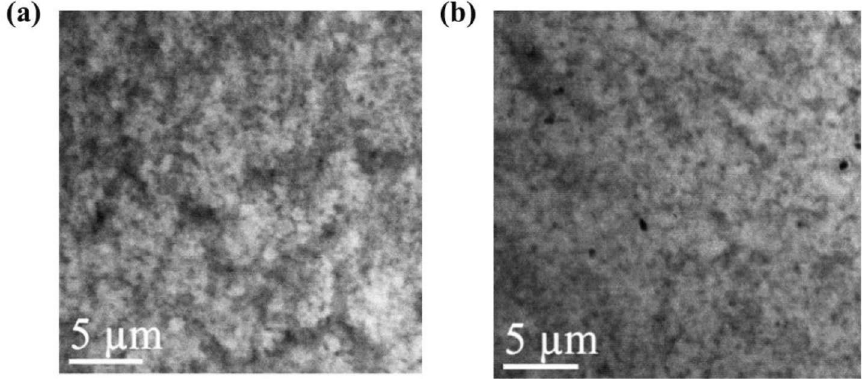
Figure 6. 80 K monochromatic CL images taken at ( a ) 514 nm for green LED wafer 1 and ( b ) 522 nm for green LED wafer 2. Both wavelengths are center wavelengths for QWs of each wafer at 80